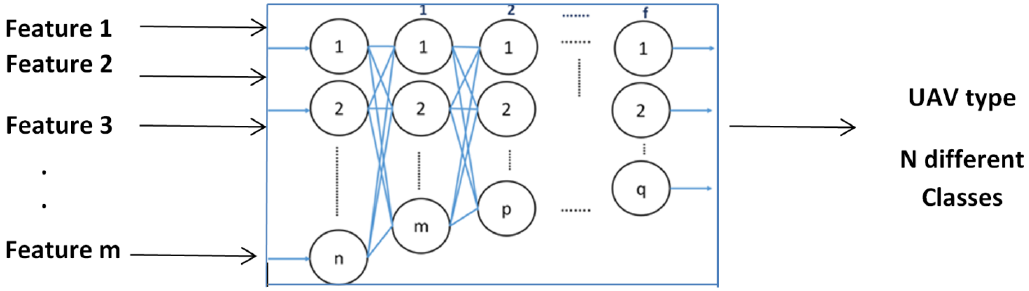
Figure 7. ML black box for choosing the best UAV based on traffic